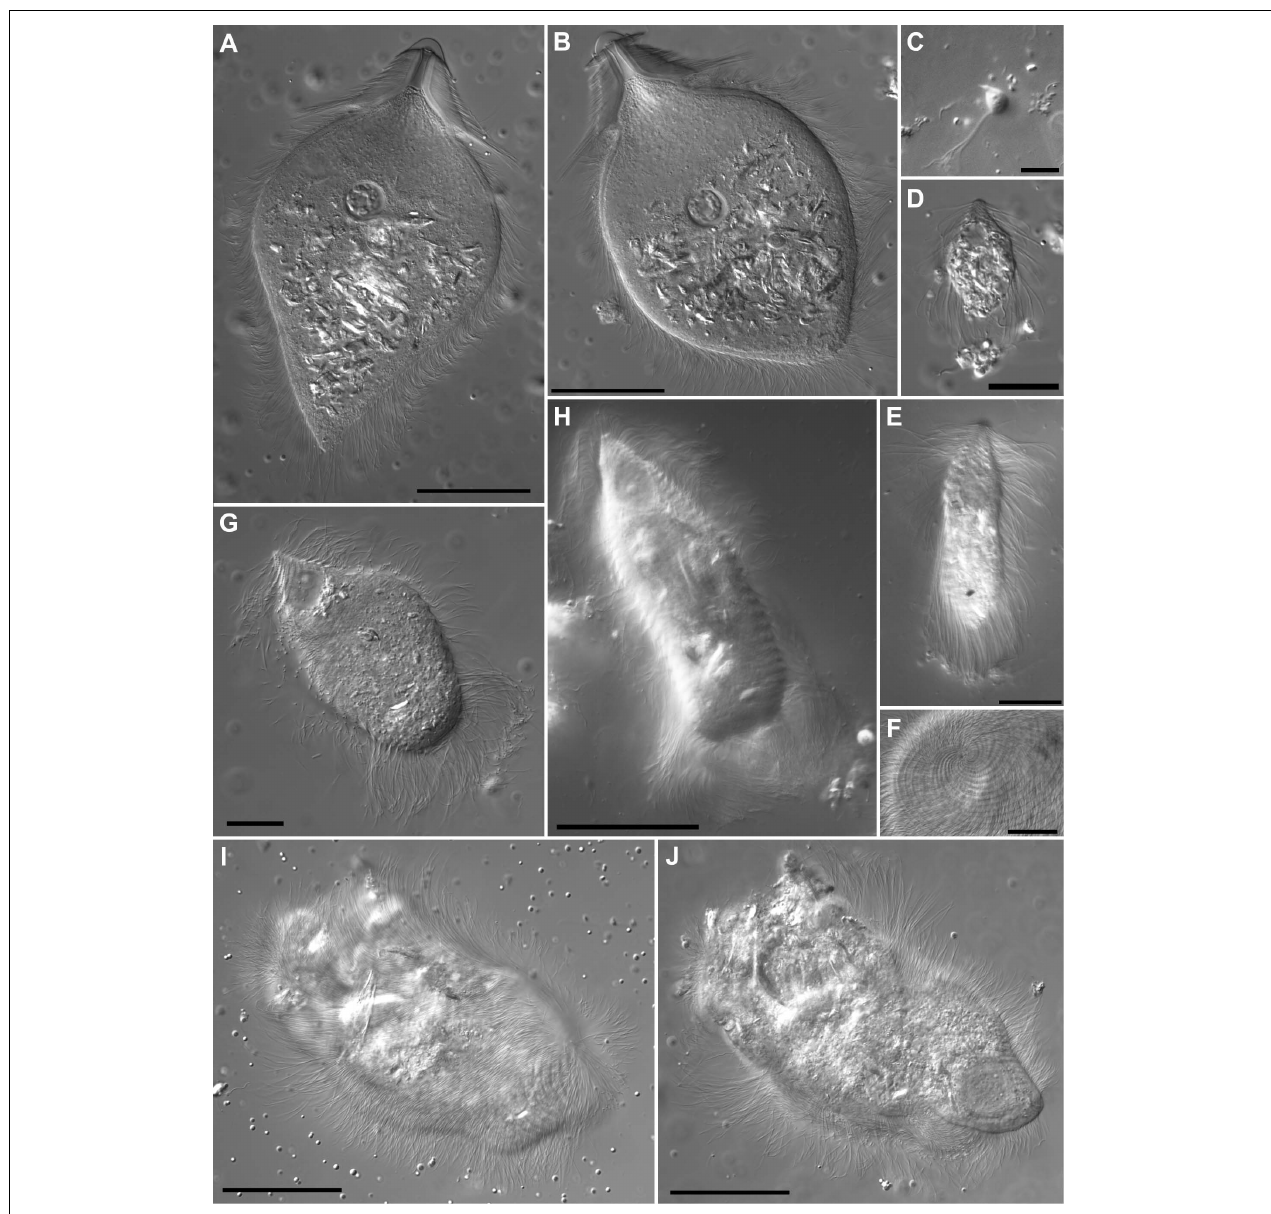
FIGURE 1 | Differential interference contrast light micrographs of Heterotermes tenuis parabasalian hindgut symbionts. (A,B) Pseudotrichonympha cells (Trichonymphida) are characterized by a prominent rostral tube with apical cap or nose cone. Flagella of three distinct length classes cover the cell body, short flagella on the rostral area, long flagella form a fringe around the base of the rostral area, and medium length flagella cover the remainder of the cell body. Both cells have ingested many wood fragments (refractile material throughout cell body) and both are shown slightly flattened by the cover slip. (A) Smooth nose cone morphotype. (B) Morphotype with marginal ridge on nose cone. (C) Cthulhu cells (Honigbergiellida) are small and bear several apical flagella. (D,E) Cononympha cells (Spirotrichonymphida) with characteristic apical pseudorostrum in which flagellar bands form a spiral staircase-like structure. (D) Smaller morphotype with central to anterior nucleus location and detritus adhering to the posterior flagella. (E) Larger morphotype with more elongate shape and centrally located nucleus. (F–J) Holomastigotoides (Spirotrichonymphida). (F) Origin of spiraling flagellar bands at a cell apex. (G) Acuminate apex morphotype (type 3) with prominent anterior nucleus and posterior ingested wood particles. (H) Bottle-shape morphotype with anterior nucleus, ingested wood particles, and relatively long flagella. (I,J) Large amorphous morphotype cell in two optical sections. (I) Glancing surface section with spiral flagellar bands visible. (J). Deeper optical section with large anterior nucleus visible. Scale bars: (A,B,H,I,J) 50 µ m; (D,E,F,G) 20 µ m; (C) 10 µ